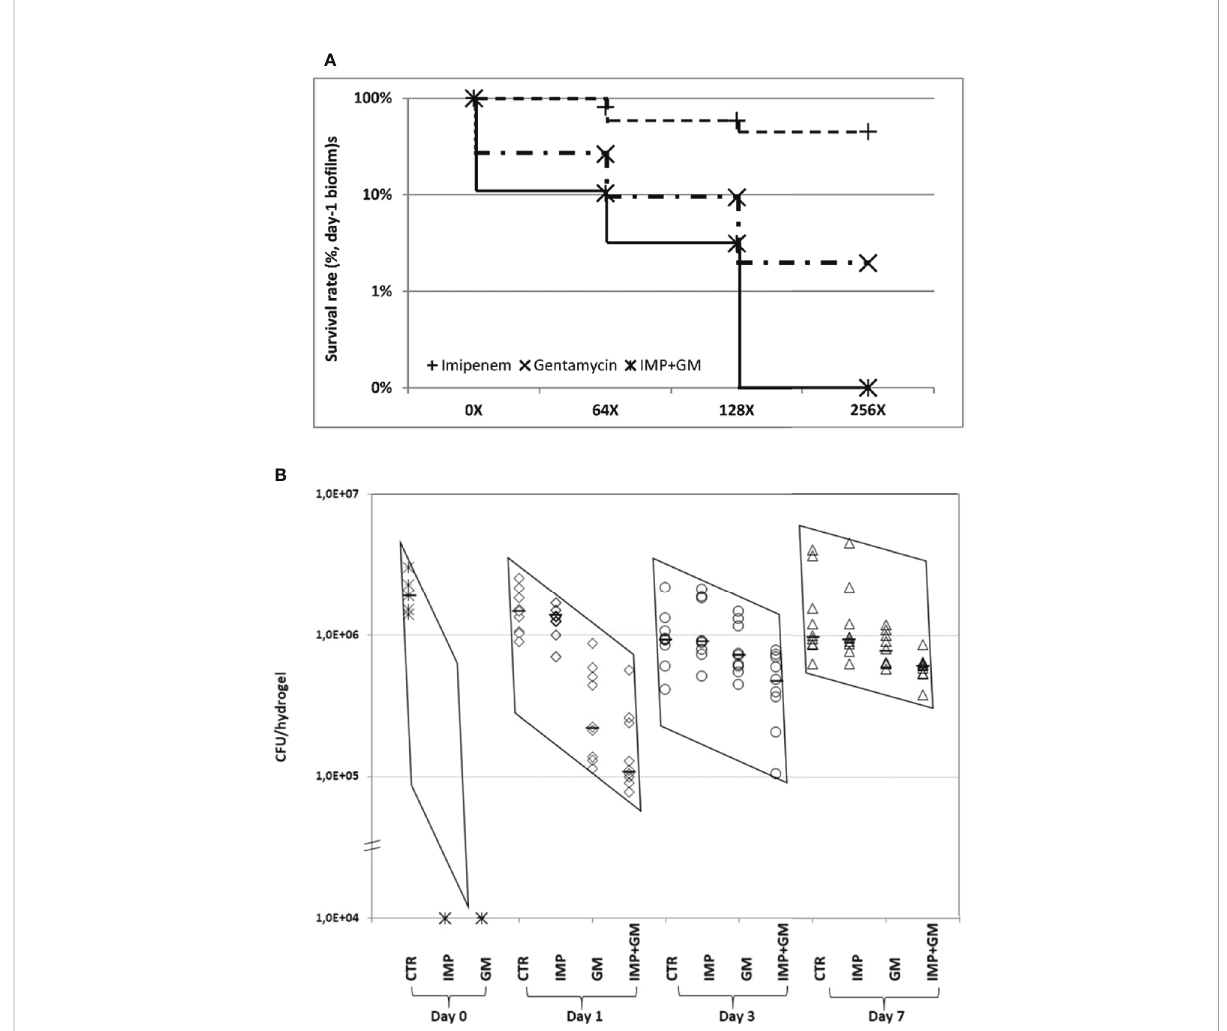
FIGURE 4 Evaluation of mono and combination therapies of b -lactam (imipenem, IMP) and/or aminoglycoside (gentamycin, GM) in P. aeruginosa PAO1 bio fi lms in vitro (A) and in vivo ( B ). (A) Comparing the doses of 0×, 64×, 128×, and 256× MIC in monotherapy or combination therapy, it appears that higher concentrations of antibiotics exhibited stronger killing against the bio fi lm bacteria. However, signi fi cant difference was only seen in the combination treatment, p < 0.02. Increasing the dose from 64× to 128× MIC and 128× to 256× MIC in monotherapy did not show signi fi cant differences. (B) Bacteria in day 0 bio fi lms were 100% killed by IMP or GM alone at 64× MIC, which is consistent with the in vitro fi ndings. In contrast, IMP monotherapy at 128× MIC killed <10% and <3% of the bacteria in day 1, 3, and 7 bio fi lms, respectively. GM alone at 128× MIC killed 85% of the bio fi lm bacteria and exhibited better bactericidal effect than IMP ( p < 0.0001) at day 1 bio fi lms. Combination treatment at the same MIC killed 92.5%, 47.5%, and 38.5% of the bacteria in day 1, 3, and 7 bio fi lms, respectively, in which, killing rates were signi fi cantly higher than for either antibiotic monotherapy at all assessed time points ( p < 0.03). The two sharply sloped parallelograms of the data distribution indicate that antibiotic treatment was more effective in young bio fi lm infections (days 0 and 1) compared with mature bio fi lm infections (days 3 and 7). CTR, control; IMP, imipenem; GM, gentamicin; IMP + GM, imipenem + gentamicin combination. MICs: IMP, 1.25 m g/ ml; and GM, 0.5 m